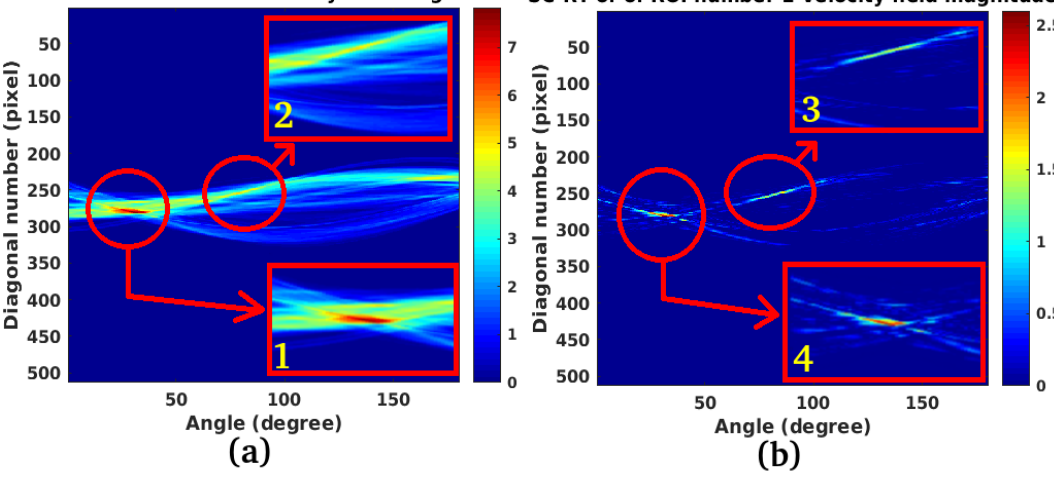
Figure 17. ( a ): RT of the displacement ROI. ( b ): Sparse component of the RT of the displacement ROI.